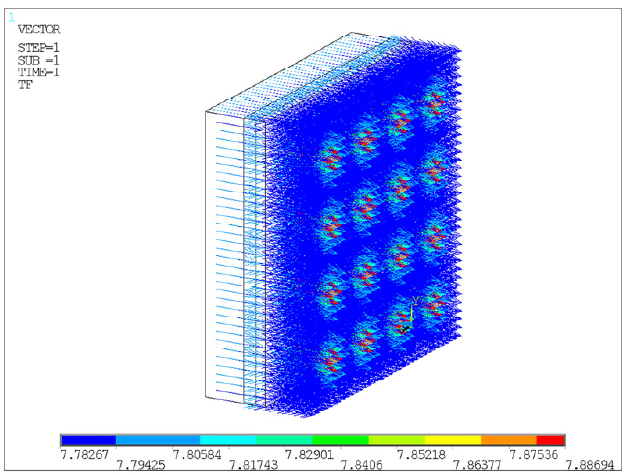
Figure 15. S-80XPS heat flux vector diagram. Note: X, Y, and Z are the directions of the coordi- nates.